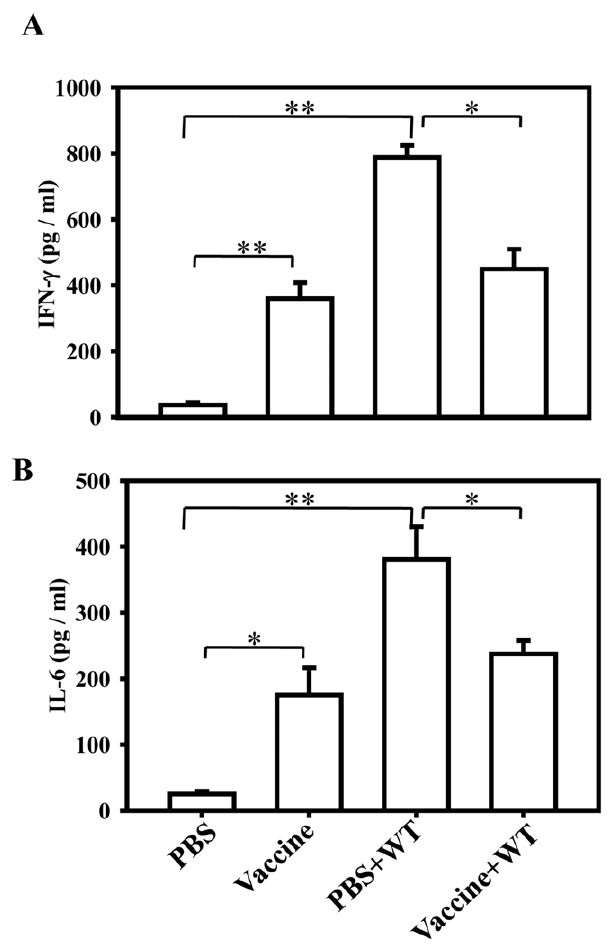
Figure 7. Analysis of serum cytokine levels with single dose of vaccination. (A) IFN- c (B) IL-6. Group of mice were orally given PBS or STM D hfq (10 8 ) and then challenged with STM-WT (10 7 CFU/mouse) at 7 th post vaccination. Serum was collected on 7 th day post vaccination (from unchallenged mice) and 7 th day post challenge (from challenged mice) and cytokine levels were measured using ELISA. Data is representative of two independent experiments (n=4-5). Statistical significance was defined as follows: (*p , 0.05; ** p , 0.005) (Student’s t test).